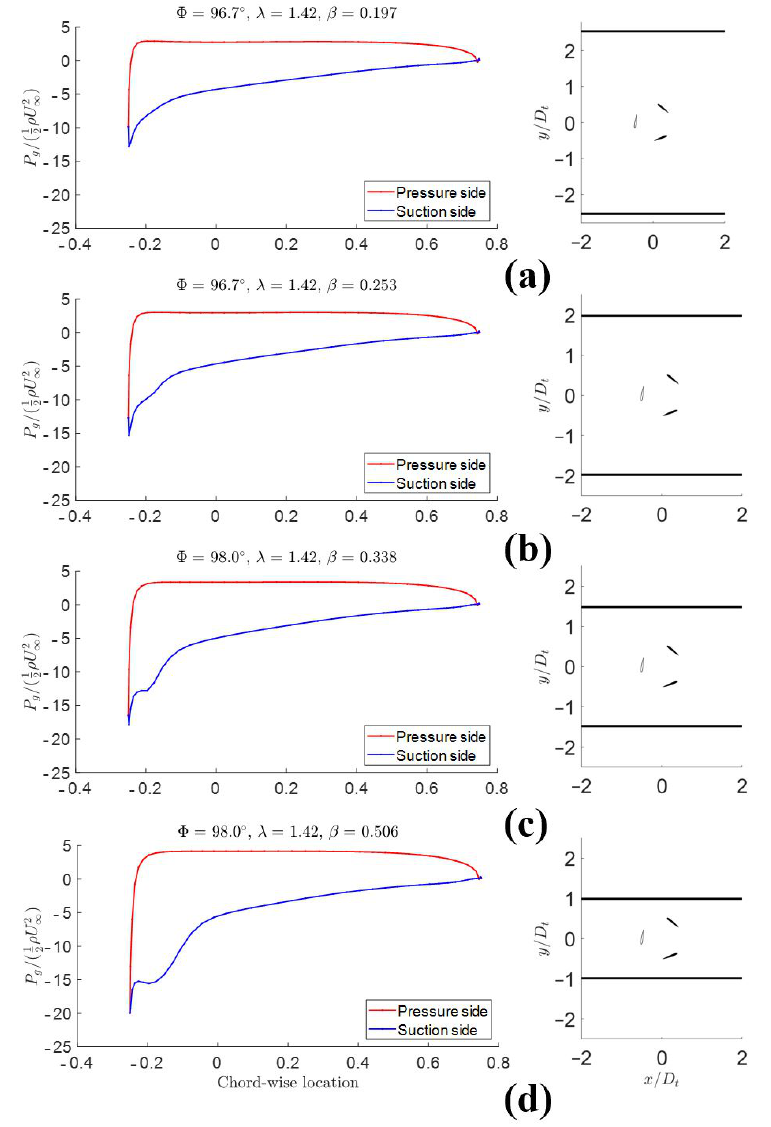
Figure 10. The pressure loading on one of the turbine blades at its maximum torque angle of 4 blockage ratios: 19.7% ( a ), 25.3% ( b ), 33.8% ( c ), and 50.6% ( d ). The relevant blade is colored in white on the right